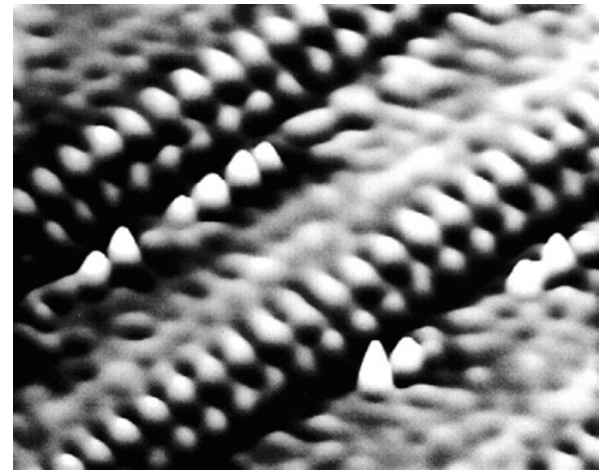
Figure 3. On anhydrous crystal surfaces the lattice units are arran- ged in layers terminating in ‘steps’. This STM image shows the step- like layers on a crystal face at which further crystal growth or disso- lution are believed to occur. (From Stumm 5 ,